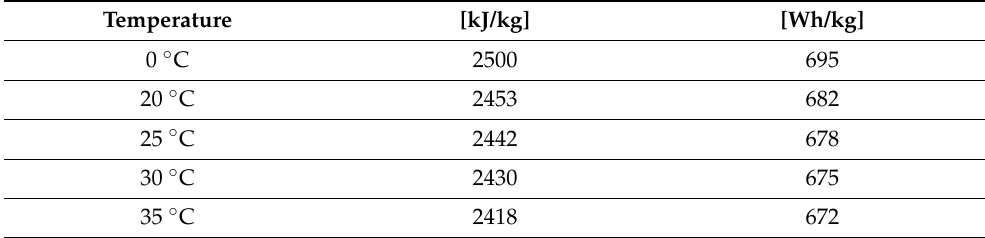
Table 4. Heat energy for vaporization of water